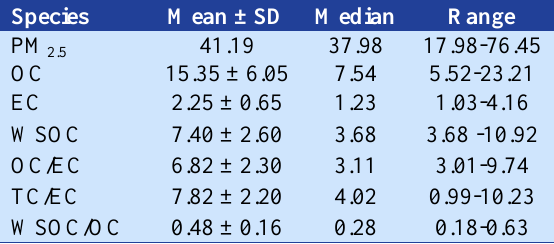
Table 1. Mass concentration of PM